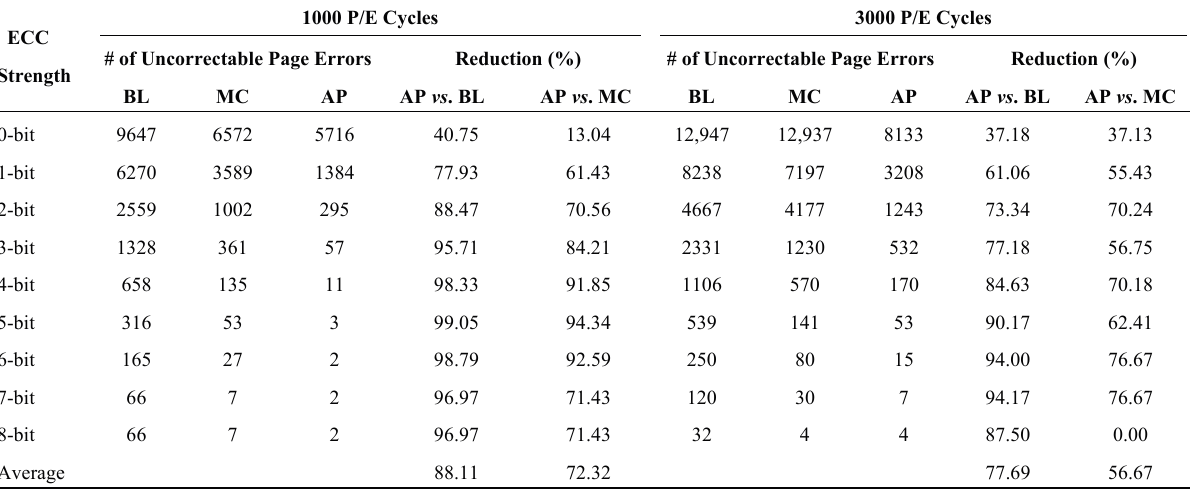
Table 5. The number of uncorrectable page errors for Baseline, Meta-Cure, and Asymmetric Programming with different ECC strengths with a P/E cycle of 1000 and a P/E cycle of